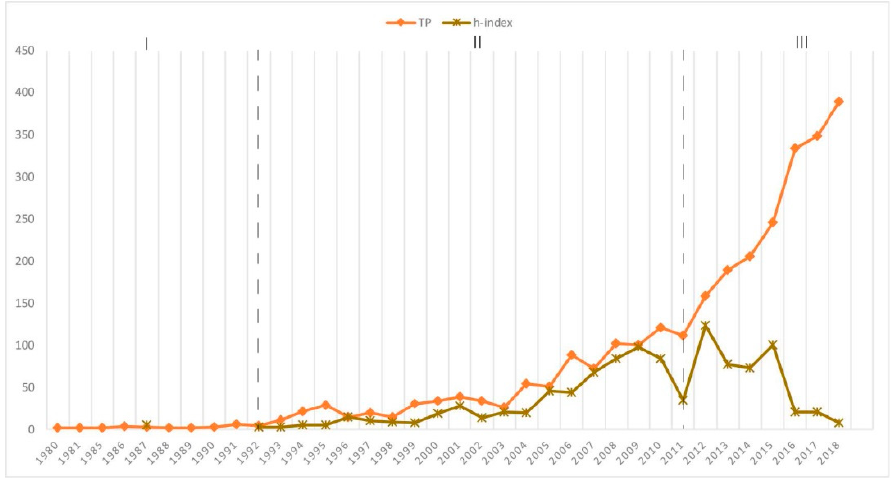
Figure 1. Line chart of TP and H change from 1980 to 2018. (TP value, total number of articles per year; H value, influence of articles per